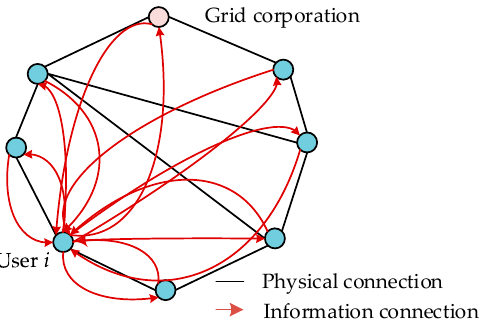
Figure 2. The information flow between user i and other nodes in blockchain-enabled DR network.